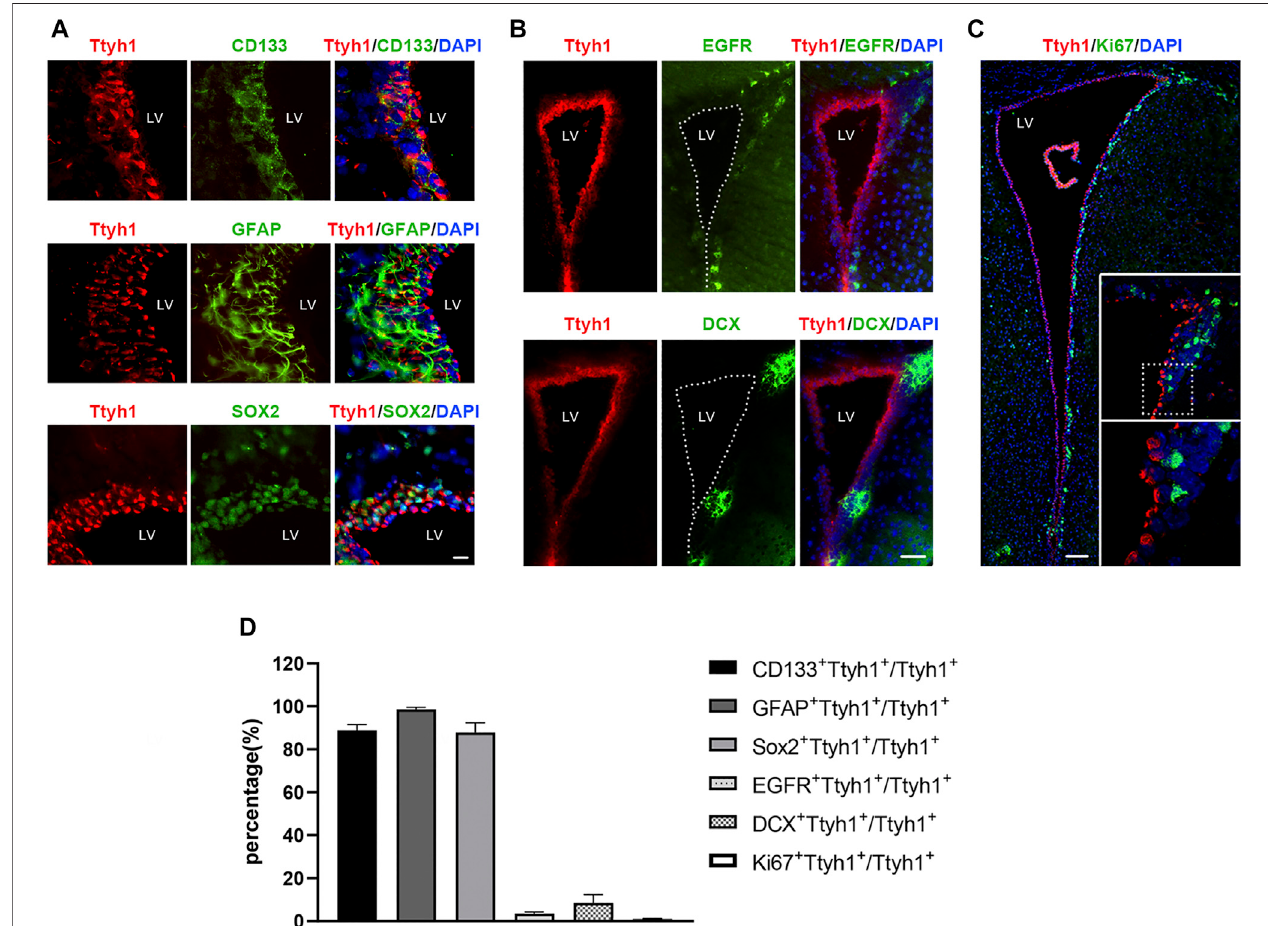
FIGURE 1 | Ttyh1 is expressed in Ki67 - quiescent NSCs in SVZ. (A) Double-labeling of Ttyh1 and NSC markers. Ttyh1 co-labeled cells with CD133, GFAP and Sox2 at high frequency in SVZ. (B) Double-labeling of Ttyh1 and TAP or neuroblast cell markers. Ttyh1 seldomly labeled EGFR + and DCX + cells. (C) Double-labeling of Ttyh1 and proliferative cell marker Ki67. Ttyh1 completely were not co-labeled with Ki67 in entire SVZ region. The non-overlapping of Ttyh1 + and Ki67 + signals are showed in magni fi cations within white rectangles (the lower fi eld is the magni fi cation of the dotted rectangle in upper fi eld). (D) Statistics of the proportions of co- labeledcellsinTtyh1 + cells.Scalebar (cid:2) 10 μ minA,Scalebar (cid:2) 50 μ minB,Scalebar (cid:2) 100 μ minC,Scalebar (cid:2) 10 μ minD. n (cid:2) 3forallexperiments.Dataareexpressed as mean ± SEM. LV, lateral